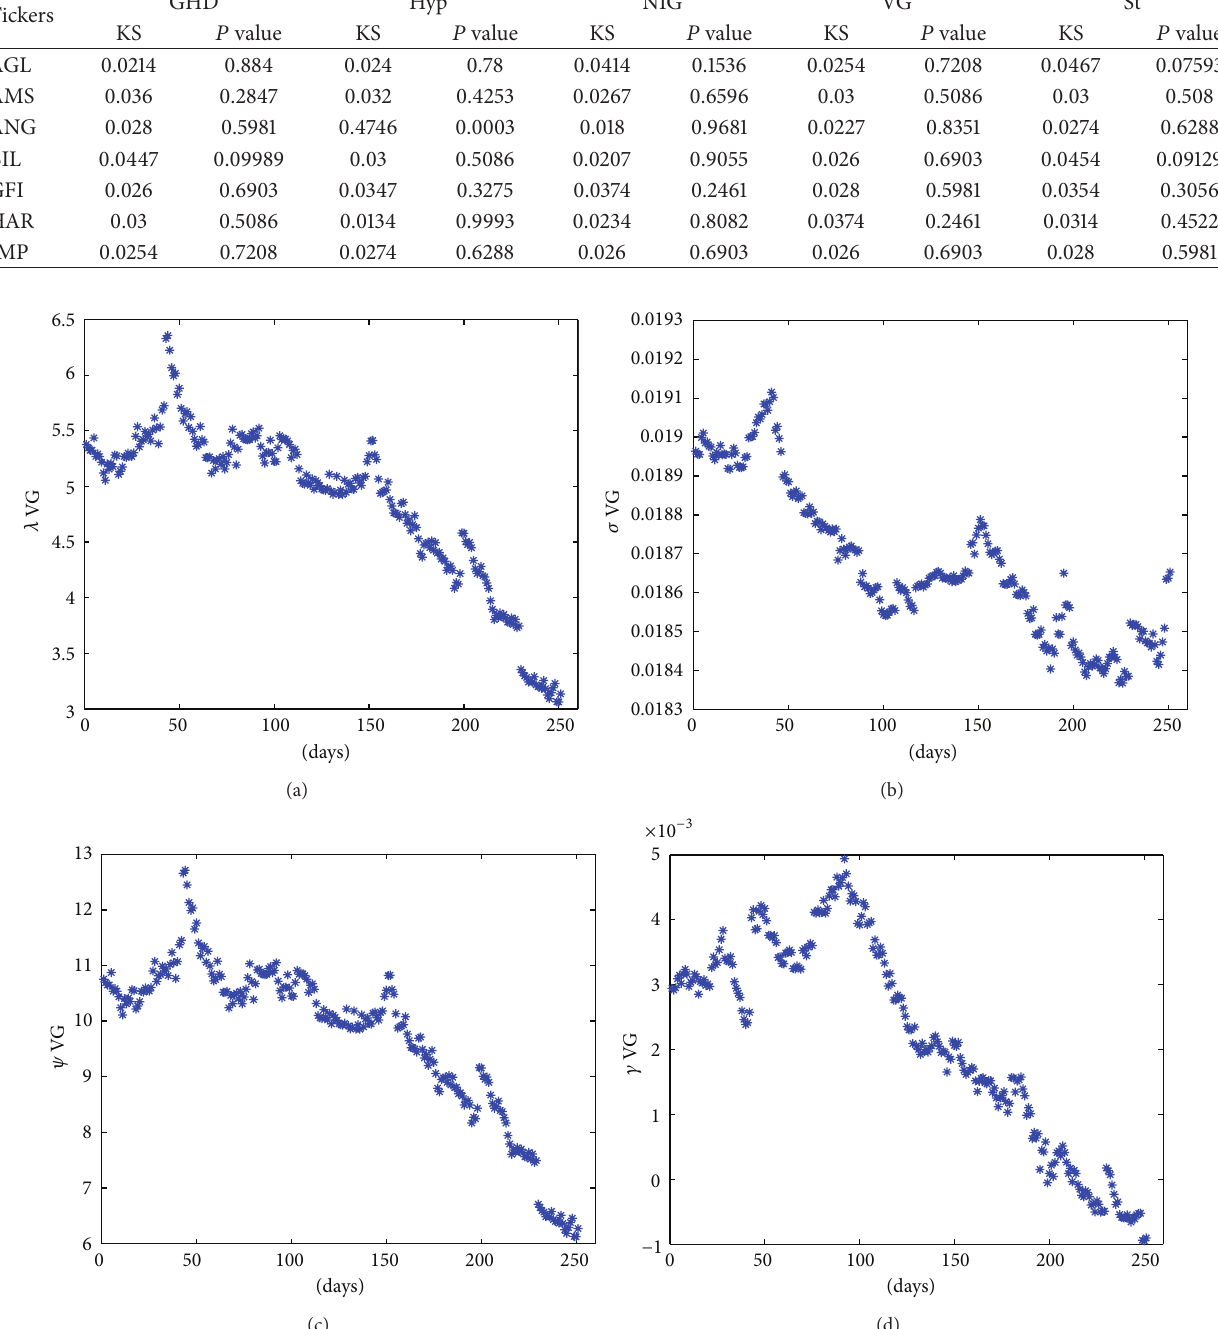
Table 4: Kolmogorov distance.